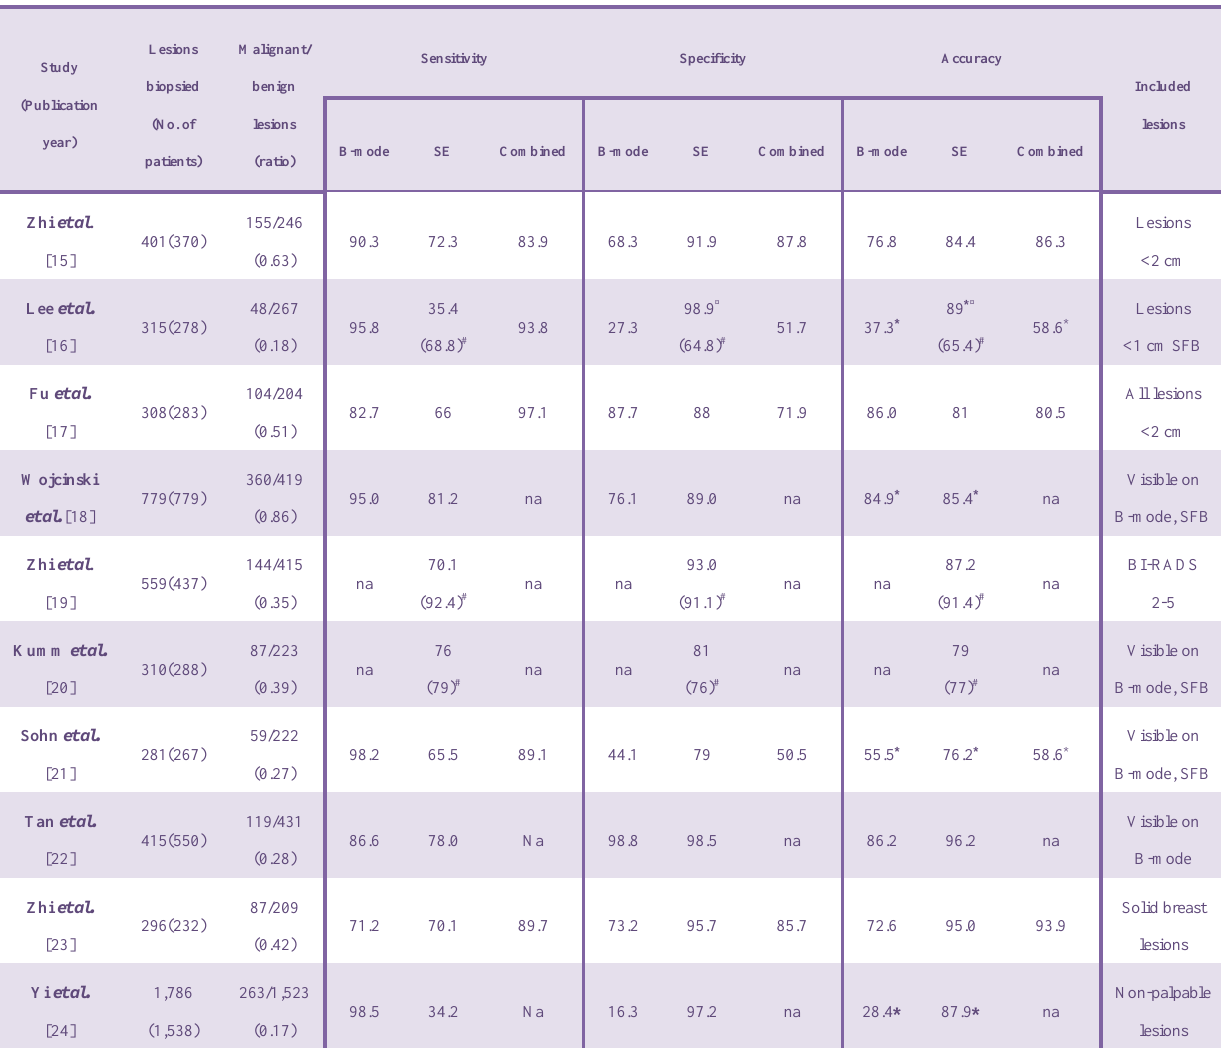
Table 1. Diagnostic values from the 10 largest published studies on semi-quantitative elastography and breast cancer. All listed studies used a five-point scale with a cut-off value between 3 and 4 for assessing malignancy. ( * ) Accuracy not reported in the paper, but calculated for this table. (¤) Cut-off values not reported in the paper, but reconstructed for this table. (#) Numbers are the diagnostic values of SR-measurements. (SFB) Scheduled for Biopsy.